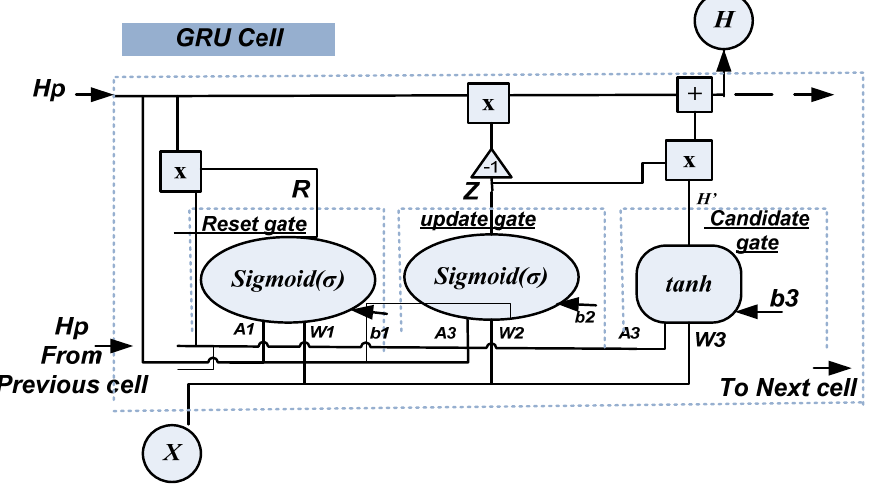
Figure 6. Internal architecture of GRU cell.